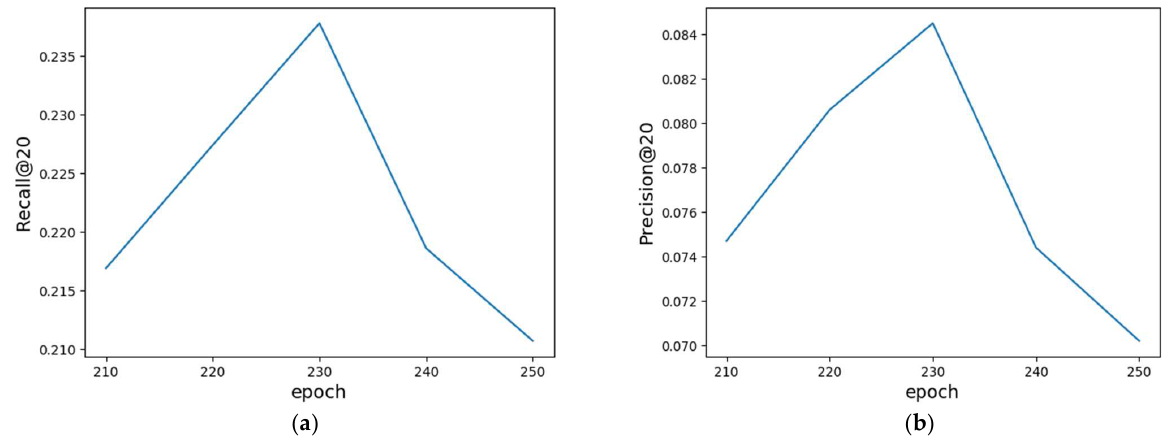
Figure 7. Effects of hyper-parameter epoch in terms of Recall@20 and Precision@20 in the dataset of MovieLens-1M: ( a ) effects of hyper-parameter epoch in terms of Recall@20; ( b ) effects of hyper- parameter epoch in terms of Precision @20.